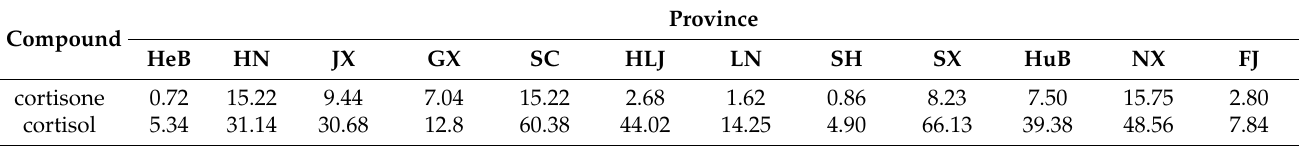
Table 2. Levels of cortisone and cortisol in aquatic food from the Chinese TDS ( µ g/kg).